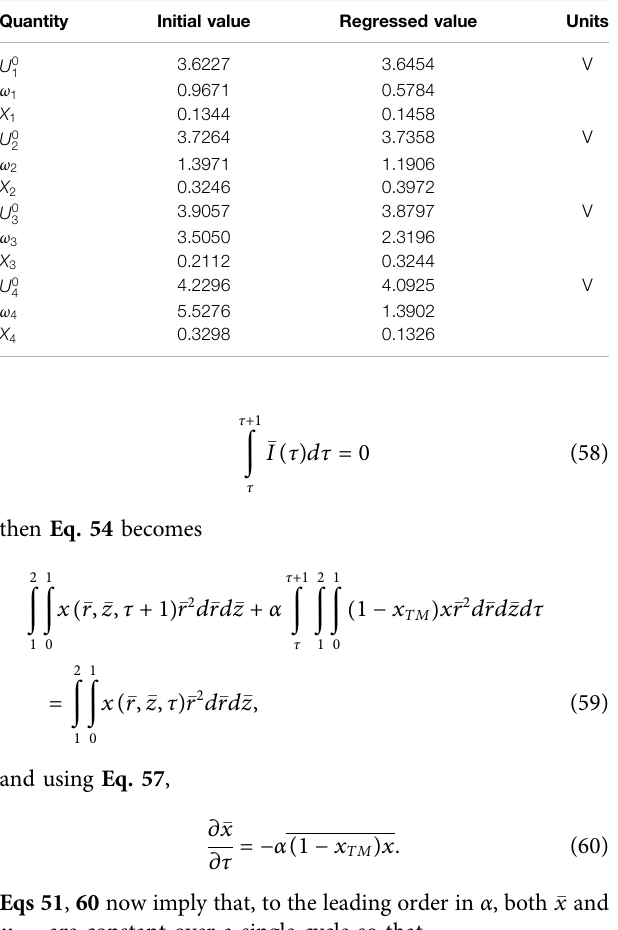
TABLE 2 | Thermodynamic parameters and properties used in the simulations. The initial values are from the work of Verbrugge et al. (2017). Note that X 4 (cid:2) 1 − X 1 − X 2 − X 3